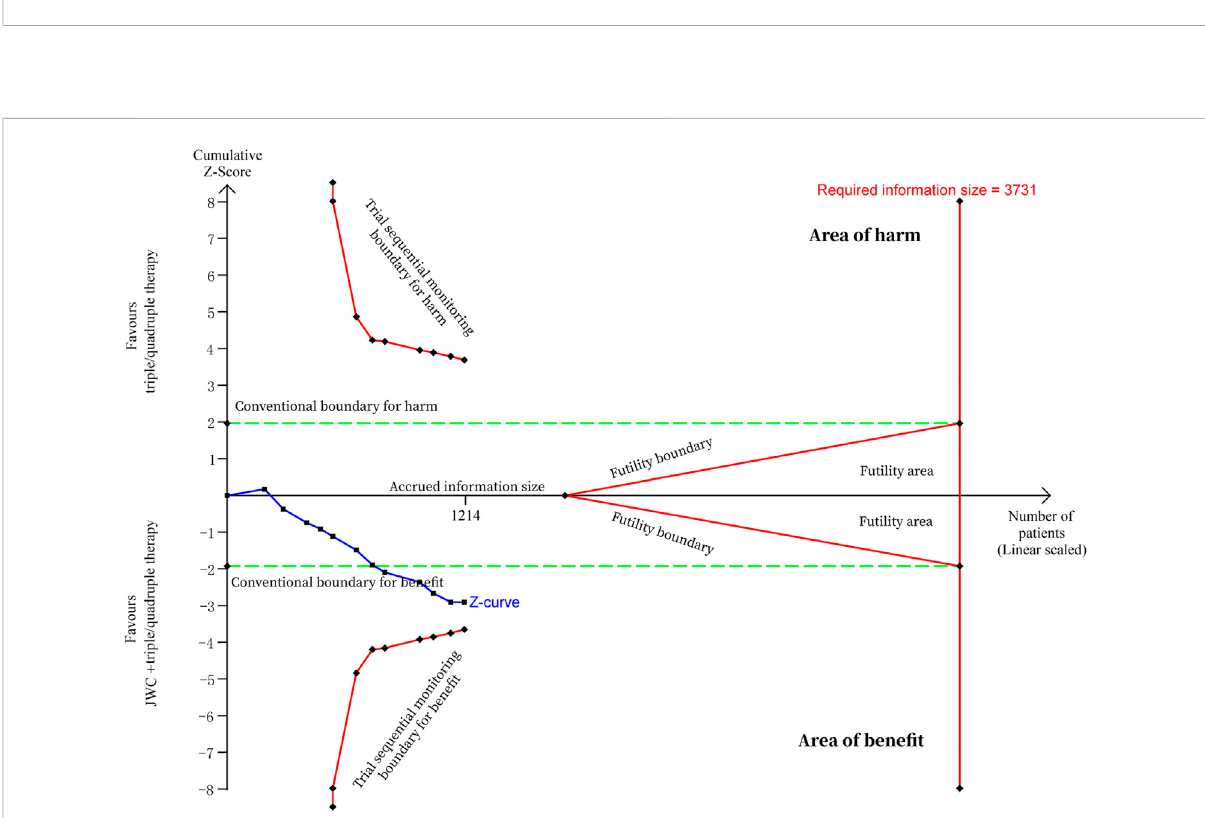
FIGURE 5 Trial sequential analysis of H. pylori eradication rate after JWC with the duration of 2